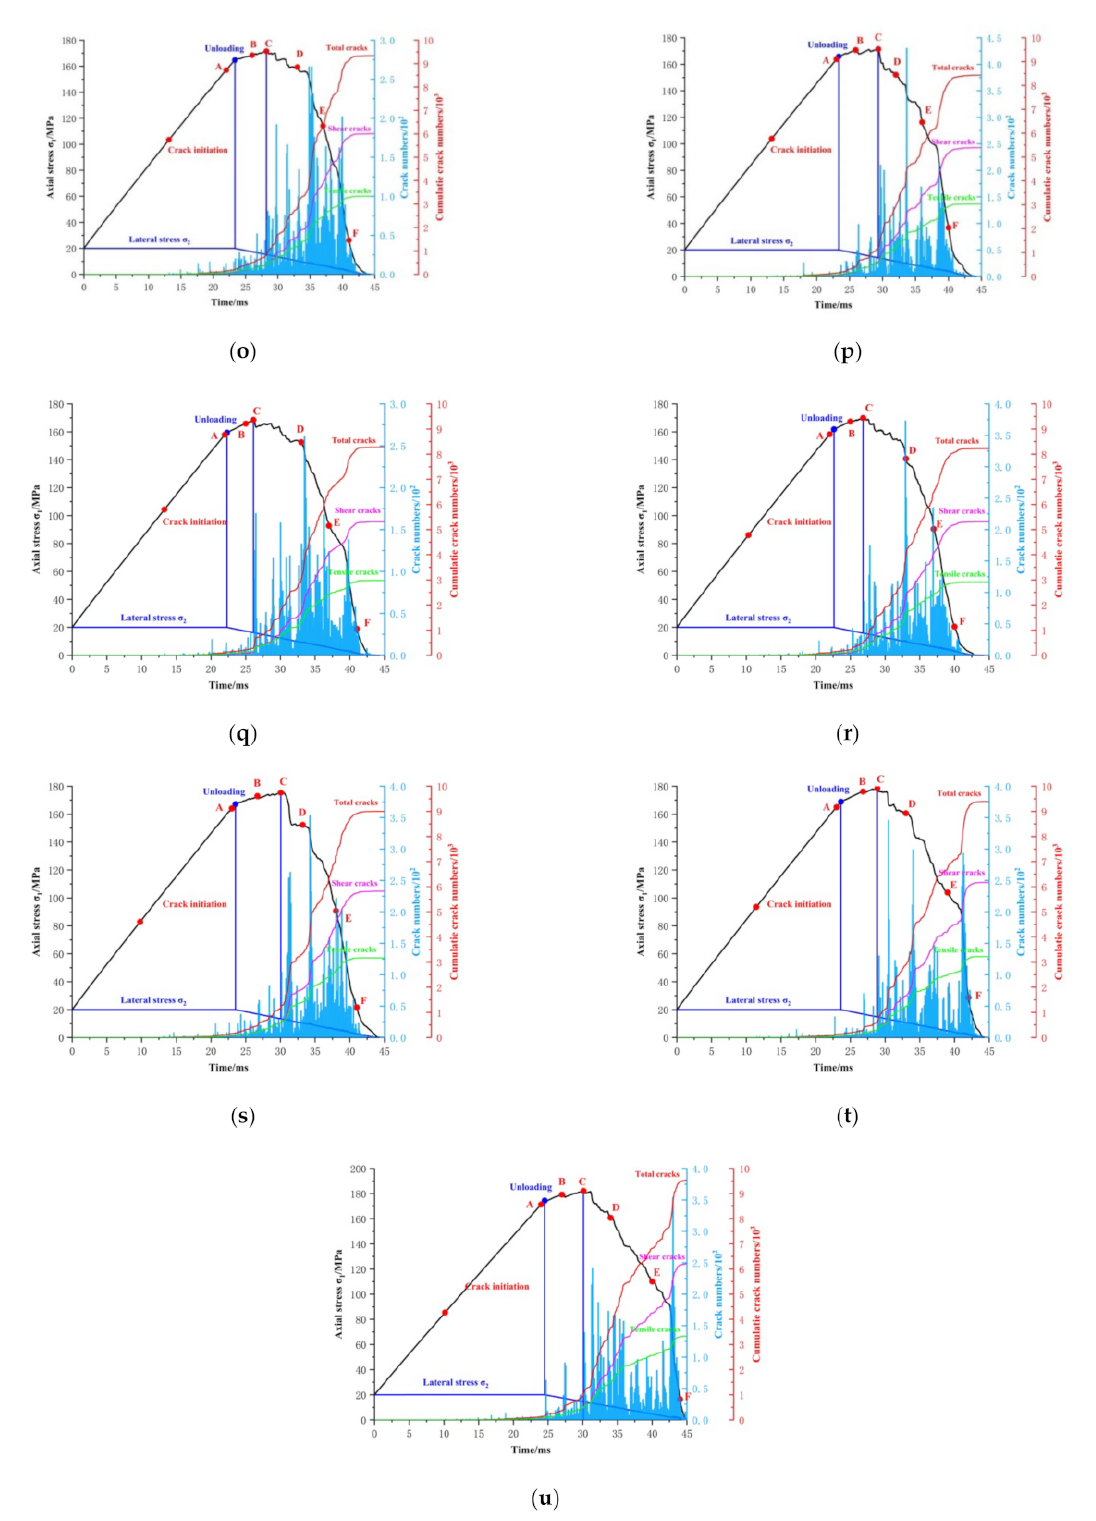
Figure 7. Changes in axial stress, crack numbers and cumulative crack numbers with time for all types of granite specimens under coupled biaxial loading and unloading conditions. ( a ) a-0; ( b ) a-15; ( c ) a-30; ( d ) a-45; ( e ) a-60; ( f ) a-75; ( g ) a-90; ( h ) s-0/90; ( i ) s-15; ( j ) s-30; ( k ) s-45; ( l ) s-60; ( m ) s-75; ( n ) c-0; ( o ) e-0; ( p ) e-15; ( q ) e-30; ( r ) e-45; ( s ) e-60; ( t ) e-75; ( u ) e-90. Point A–F: the six stages during crack development processes including the stages before peak stress (A and B), at the peak stress (C) and after the peak stress (D, E and